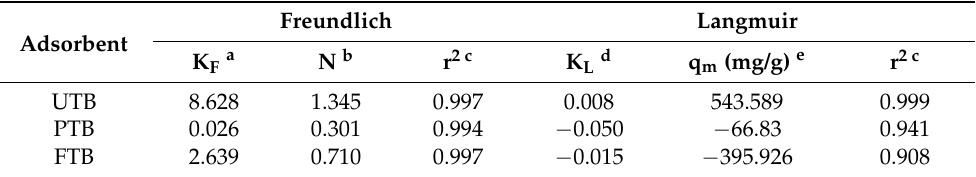
Table 1. Isotherm parameters of congo red adsorption for untreated sugarcane bagasse (UTB), alkali